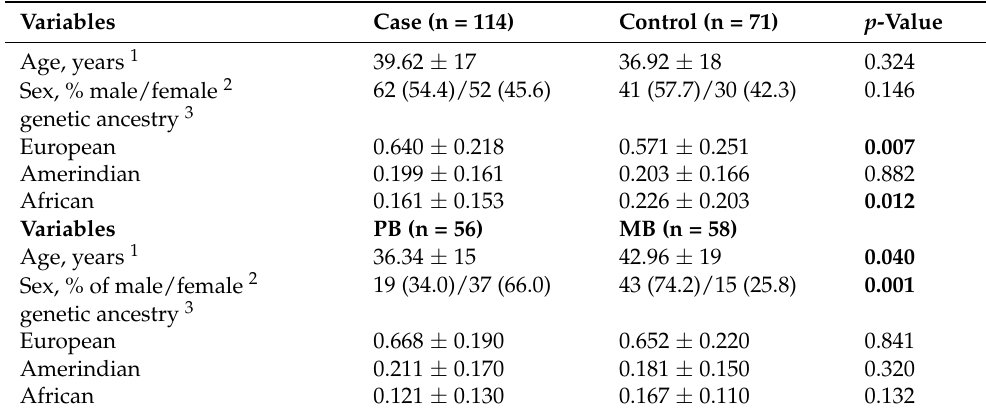
Table 1. Demographic and clinical characteristics of the sample of subjects.